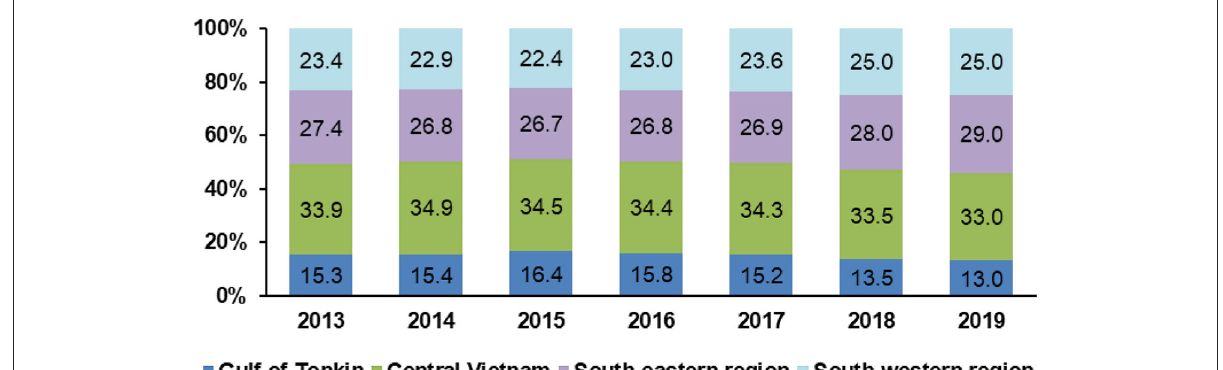
FIGURE2 Proportion of regional marine landings in Vietnam, 2013–2019. Data source: Directorate of Fisheries (2017, 2018, 2019), and General Statistics Office